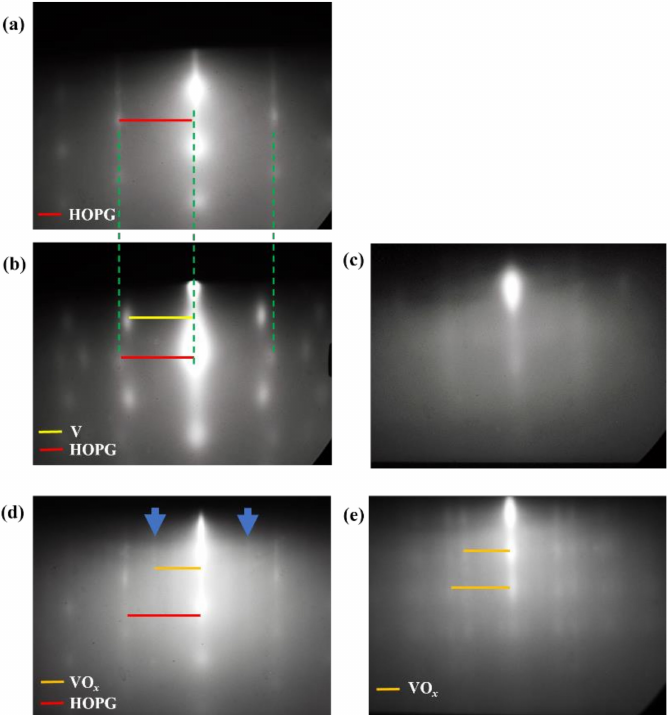
Figure 1. RHEED pattern of ( a ) clean HOPG (after degassing); ( b ) sample c 1 , 0.45 nm V deposition on HOPG without O 2 ; ( c ) sample d 1 , 0.45 nm V deposition on HOPG with O 2 ; ( d ) annealed sample c 2 ; and ( e ) annealed sample d 2 . The yellow, orange and red solid lines indicate the RHEED streak spacings of V, VO x and HOPG, respectively. The green dotted lines indicate that the RHEED spacings of HOPG are the same before and after V deposition. The blue arrows mark the weak streak patterns from VO x